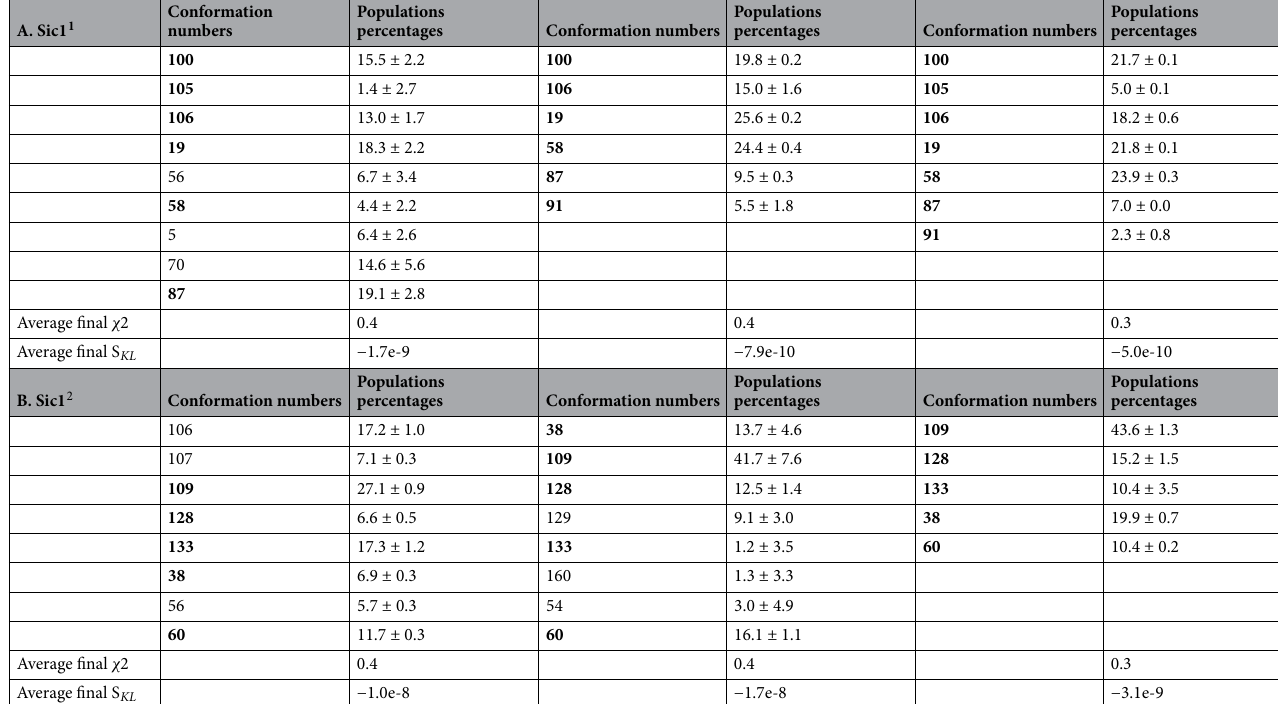
Table 1. Conformations and populations selected using BioEn 0.1.1 18 on the three sets of SAXS curves. 1 2 The conformations were generated by the runs Sic1 and Sic1 . For each SAXS curve and set of protein conformations, after ten runs starting from random values of populations and performed on the whole set of conformations, all conformations for which the sum of populations over the ten runs was larger than 0.01 were gathered, and a second run of ten additional BioEn calculations was performed on this reduced set of conformations. The average and standard deviation values of populations obtained for each selected conformation from the second set of BioEn runs, are given in the Table, along with the final average values of 2 reduced χ and of entropy S KL . The labels of conformations selected in at least two runs are written in bold. The conformations displaying average populations smaller than 1% were removed from the final set.